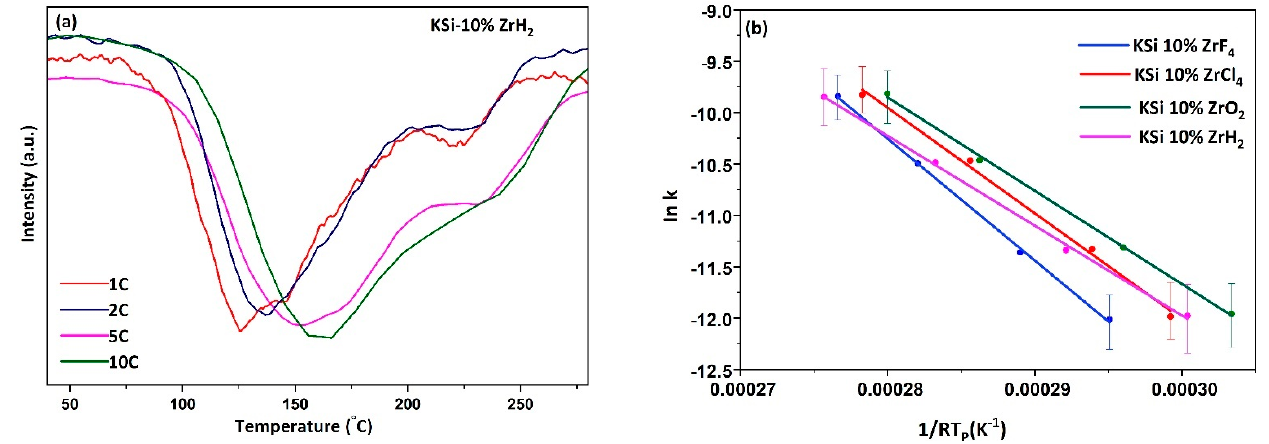
Figure 5. ( a ) DTA signals of KSi ‐ 10% ZrH 2 at different heating rates. ( b ) Kissinger plots for KSi sam ‐ ples with catalysts. Table 1. Activation energies of Zr ‐ based catalysts (with milled samples). Table 1. Activation energies of Zr-based catalysts (with milled